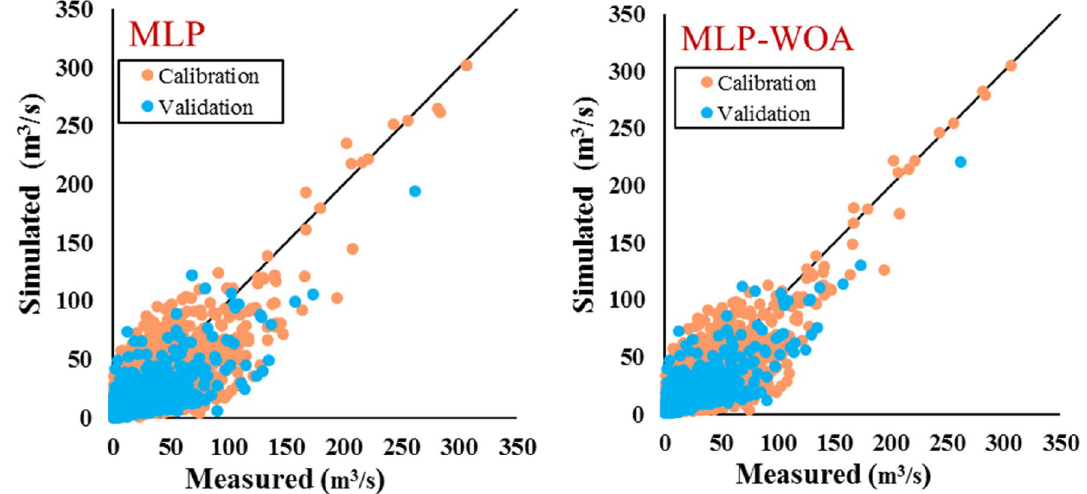
Figure 9. Scatter plots of measured vs simulated runoff on the calibration and validation phases through the MLP and coupled MLP-WOA